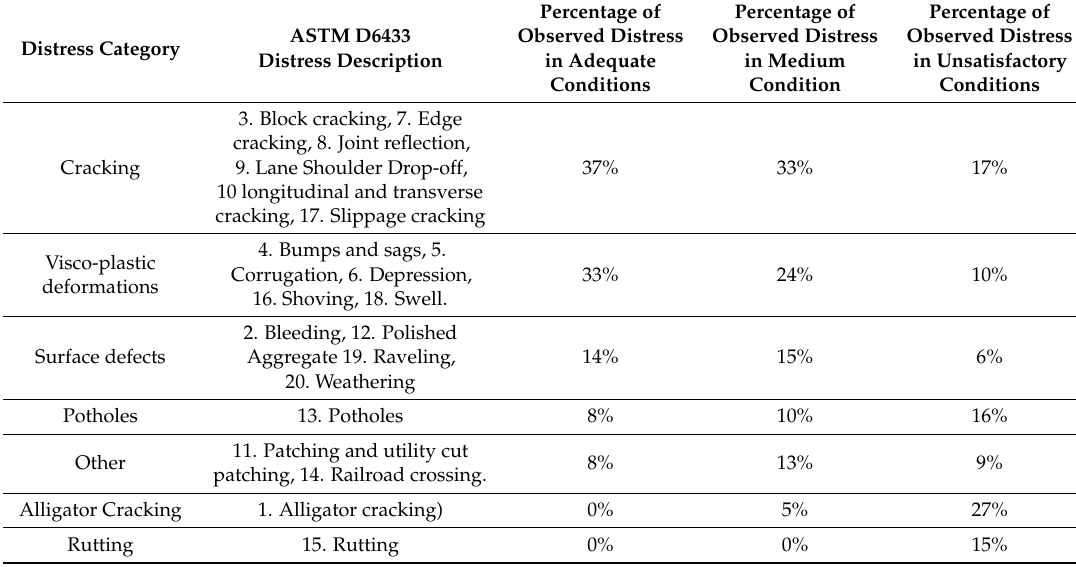
Table 3. Road pavement distress distribution by PCI condition in Urban